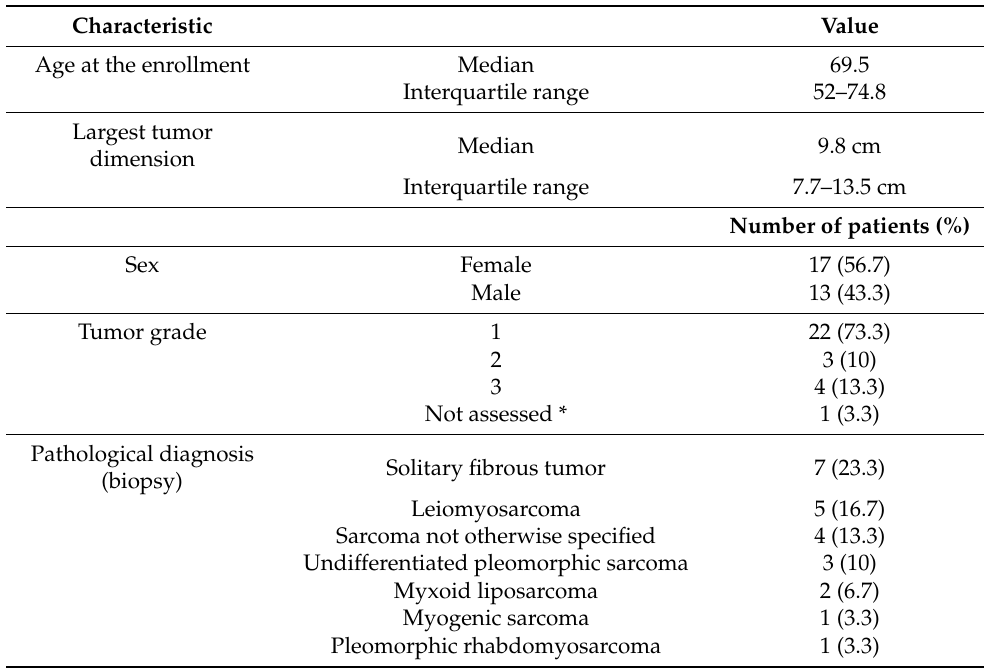
Table 1. Patient and tumor